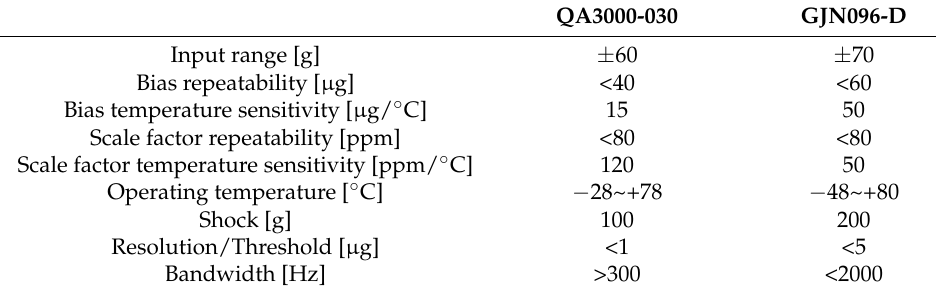
Table 1. Main performance characteristics of QA3000 and